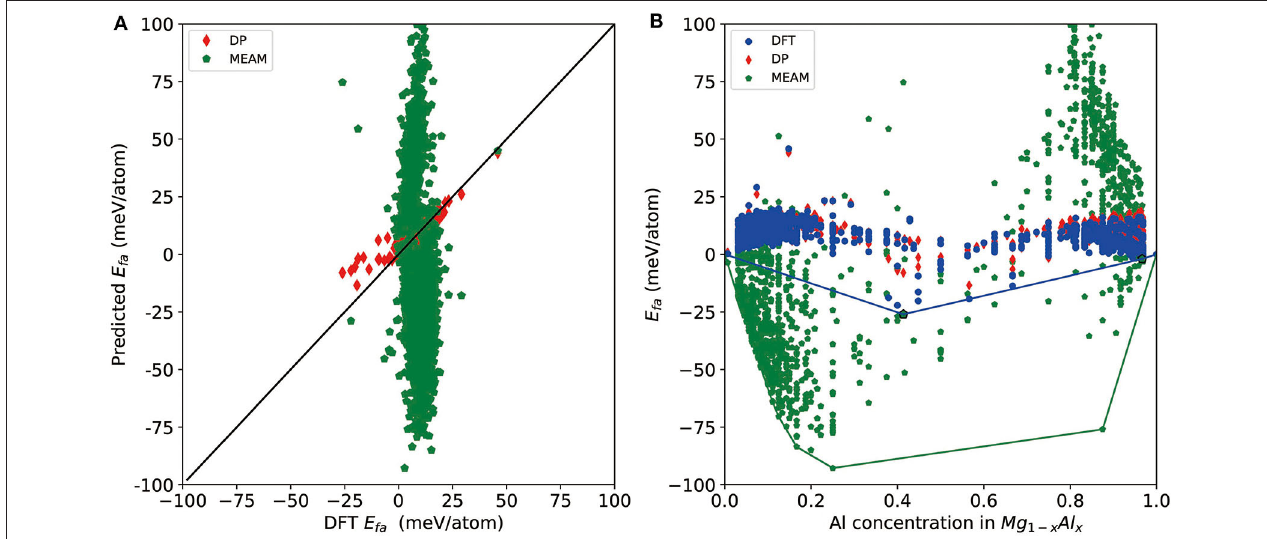
FIGURE 5 | (A) Scatter plot of the formation energy calculated by density functional theory (DFT) and Deep Potential (DP) for potentially candidate structures. (B) The formation energy as a function of molar fraction of Al atom for different Mg–Al phases where solid line denotes the convex hull constructed by DFT results. The formation energies calculated by DFT, DP, and MEAM are marked by blue circle, red diamond, and green pentagon,